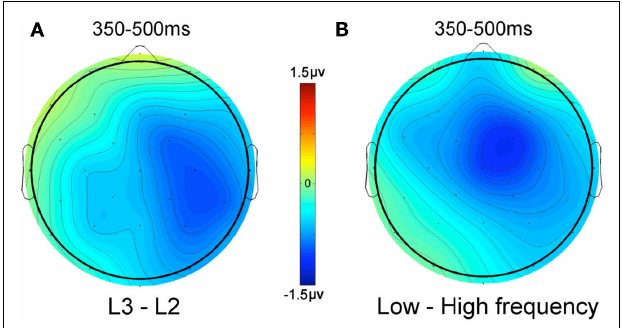
FIGURE 4 |Voltage difference maps. (A) L3 words minus L2 words, (B) low frequency words minus high frequency